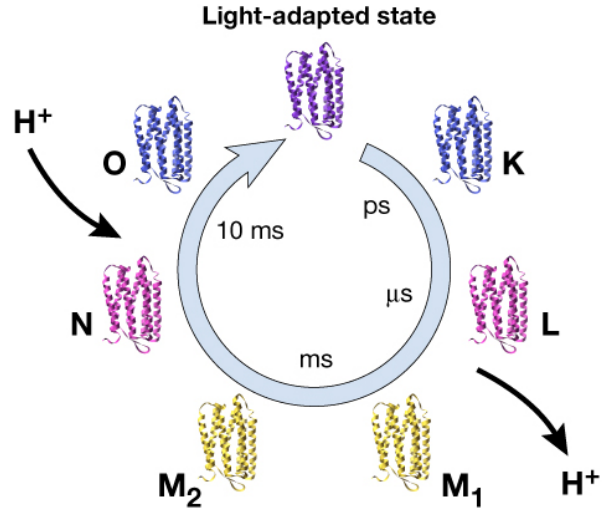
Figure 1. Photocycle of bacteriorhodopsin. Different intermedi- ates formed in the photocycle are indicated with timescale of occurrence, sequence and approximate color corresponding to their spectroscopic